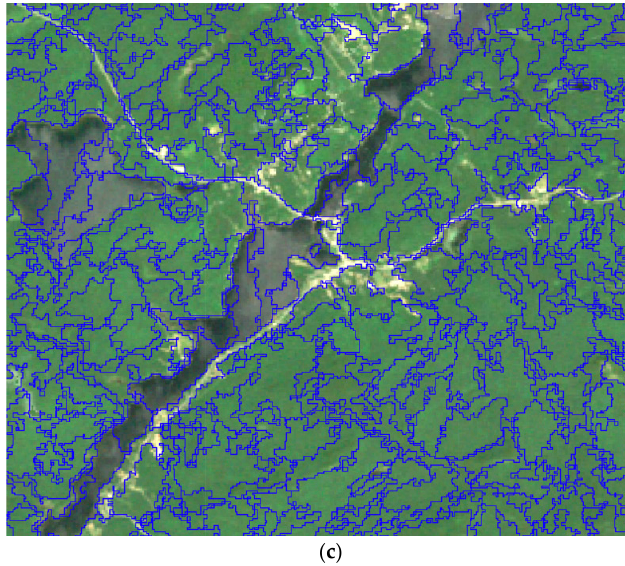
Figure 3. An example of SNIC segmentation in GEE using different seeds and same size, compactness, connectivity, and neighborhoodSize. ( a ) Landsat 5 image collection for July/01/2011 to August/31/2011. ( b ) SNIC segmentation using 60 seeds. ( c ) SNIC segmentation using 20 seeds.